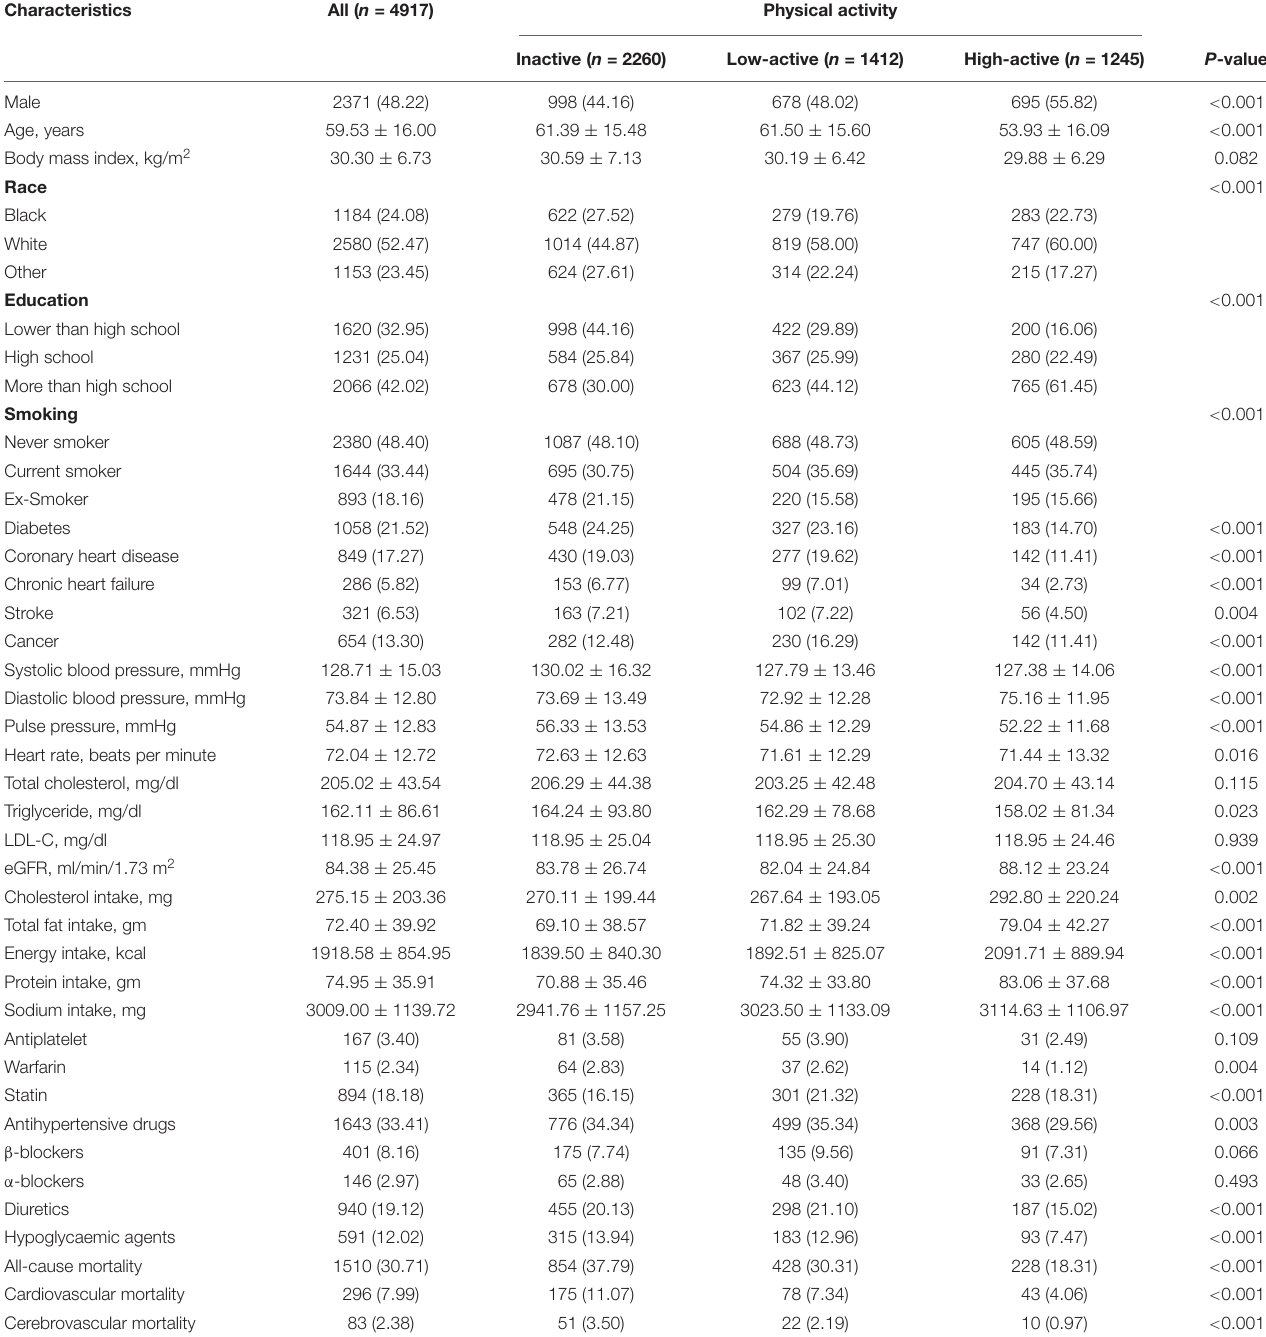
TABLE 1 | Baseline characteristics of study participants by physical activity a (PA).